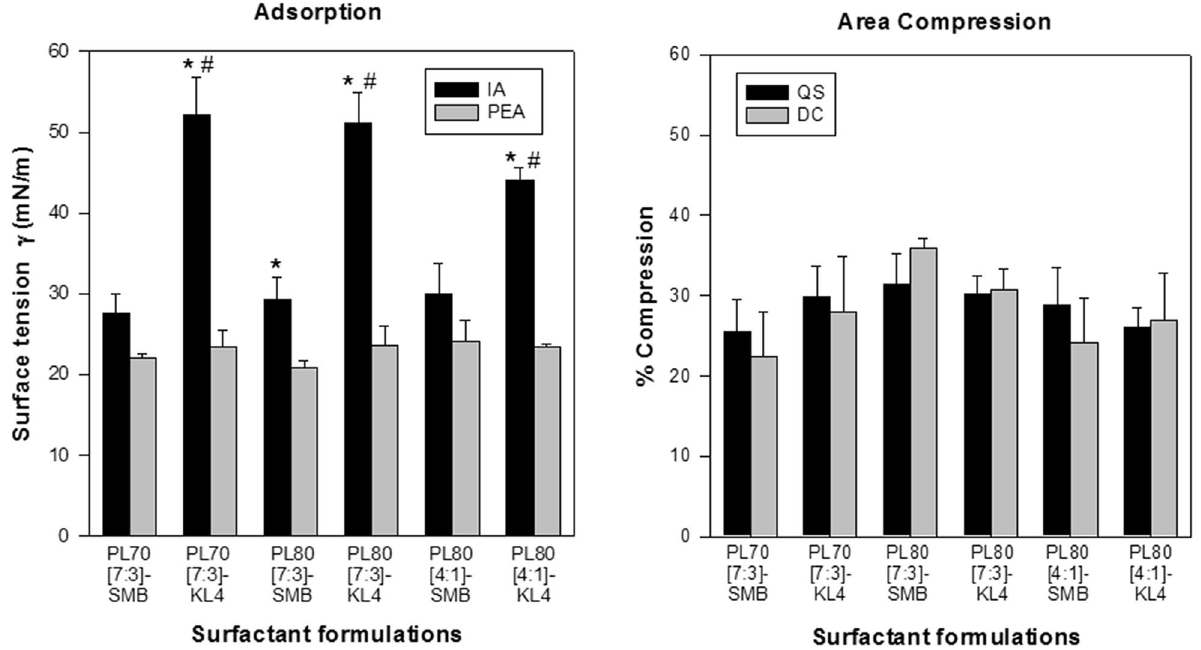
Figure 2. Mean ± SEM adsorption and area compression values of the six dry powder surfactant formulations from the 1st series. Formulations PL70[7:3]-SMB, PL80[7:3]-SMB and PL80[4:1]-SMB contained Super Mini-B (SMB) and formulations PL70[7:3]-KL4, PL80[7:3]-KL4 and PL80[4:1]-Kl4 contained KL4 as surfactant protein B (SP-B) peptide mimic. PL70 and PL80 stand for 70% and 80% phospholipids, [7:3] and [4:1] for DPPC:POPG ratios. The left-sided figure depicts initial adsorption (IA) and post-expansion adsorption (PEA) expressed as surface tension in mN/m. The right-sided figure shows % compression to reach minimum surface tension during quasi-static (QS) and dynamic cycling (DC), i.e. quasi-static cycle 4 and dynamic cycle 10. *p < 0.001 IA vs corresponding PEA values.; # p < 0.02 vs correponding SMB-surfactant. See Table 1 for details on composition of the